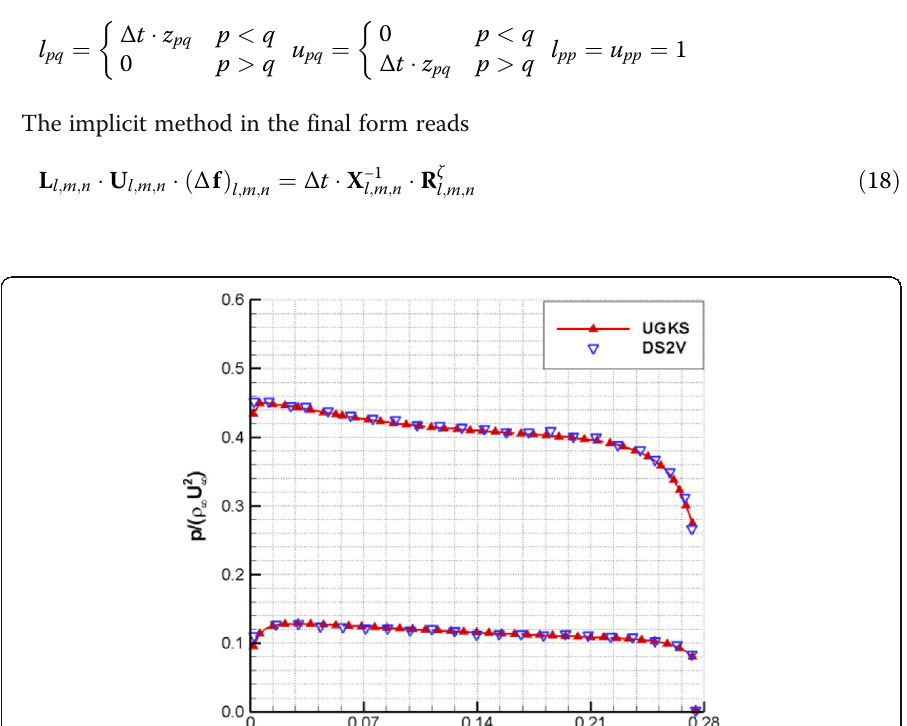
Fig. 5 Pressure distribution on the wedge surface